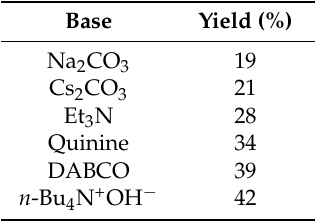
Table 1. Optimization of the base used in the Sonogashira reaction under typical reaction conditions.